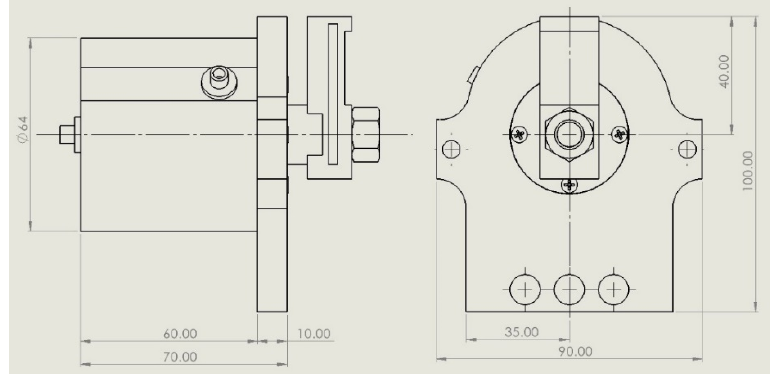
Figure 10. The main dimensions of the cylinder geometry.